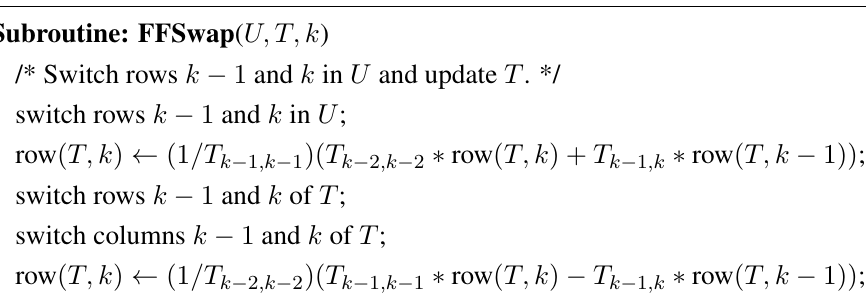
Figure 7. Fraction Free Swap